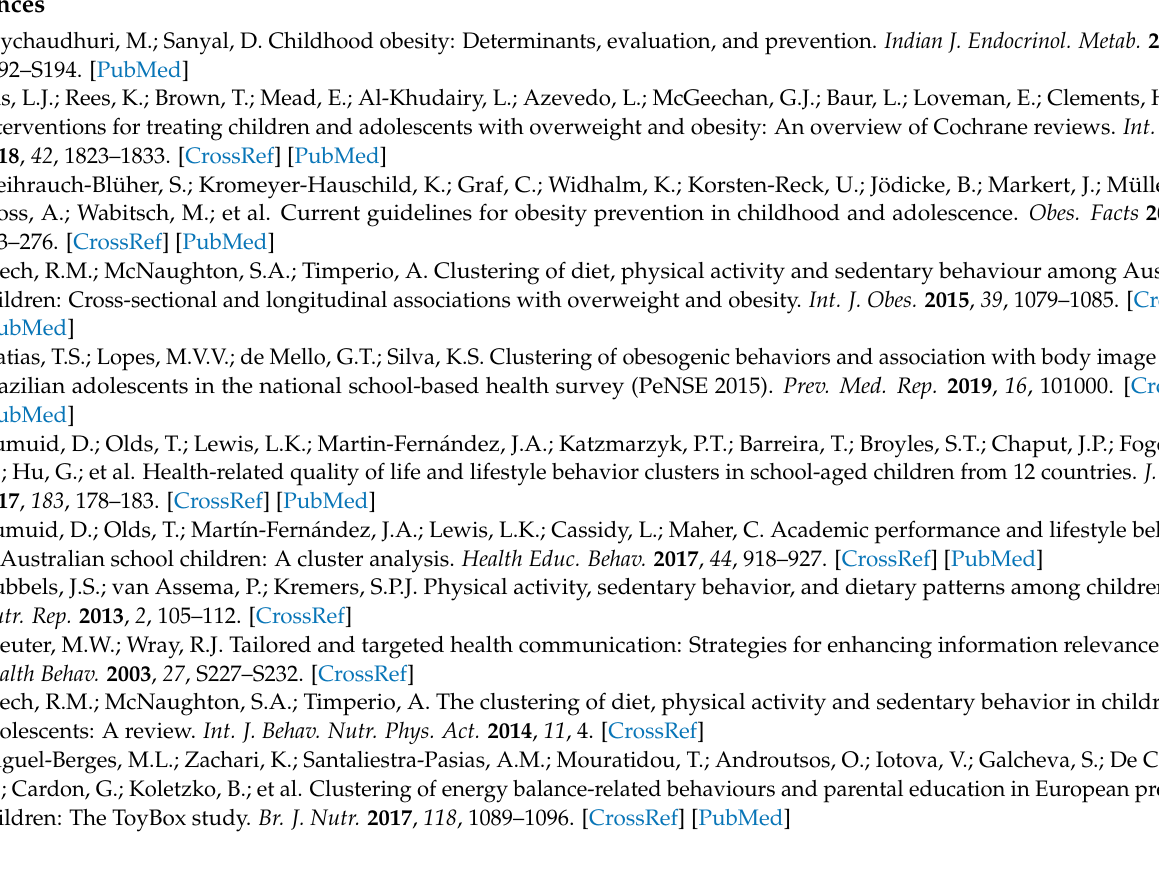
Table S4: Methodological Characteristics of included studies, Table S5: Assessment of the bias risk of studies, Table S6: Articles from their respective studies, Figure S1: Instruments used and questionnaires classification according to each behavior, Figure S2: Behavioral outcomes used to define PA, diet, and sedentary behavior in clustering procedures, Figure S3: Use of statistical procedures to evaluate the clustering between physical activity, diet and sedentary behavior among children and adolescents, Figure S4: Quantity of outcomes used in clusters